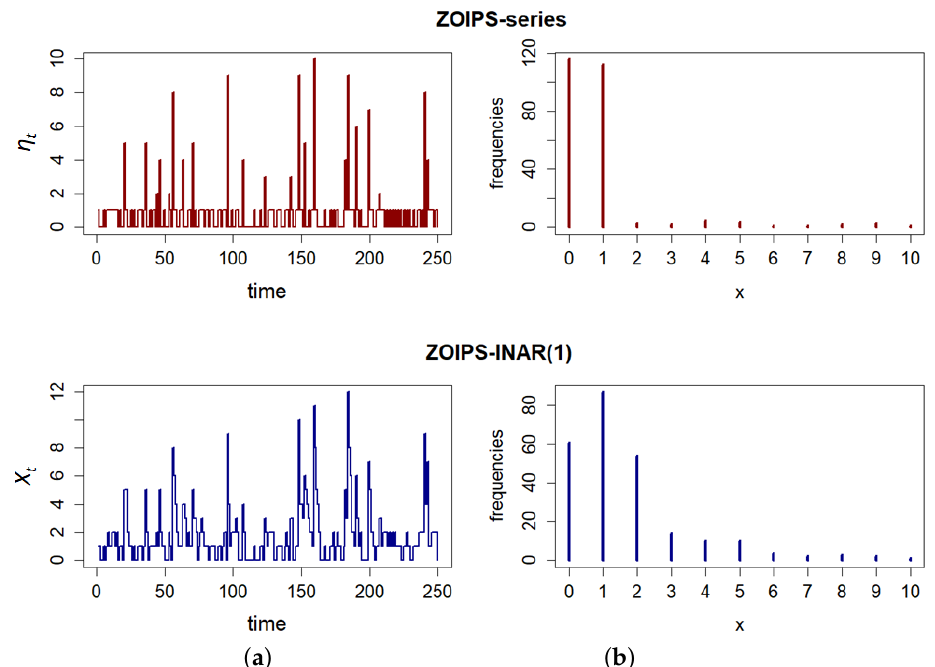
Figure 1. ( a ) Dynamics of the ZOIPS series and ZOIPS-INAR(1) process. ( b ) Empirical frequency distributions of both time series. (Parameters values are: α = 0.5, θ = 5, φ 0 = φ 1 =